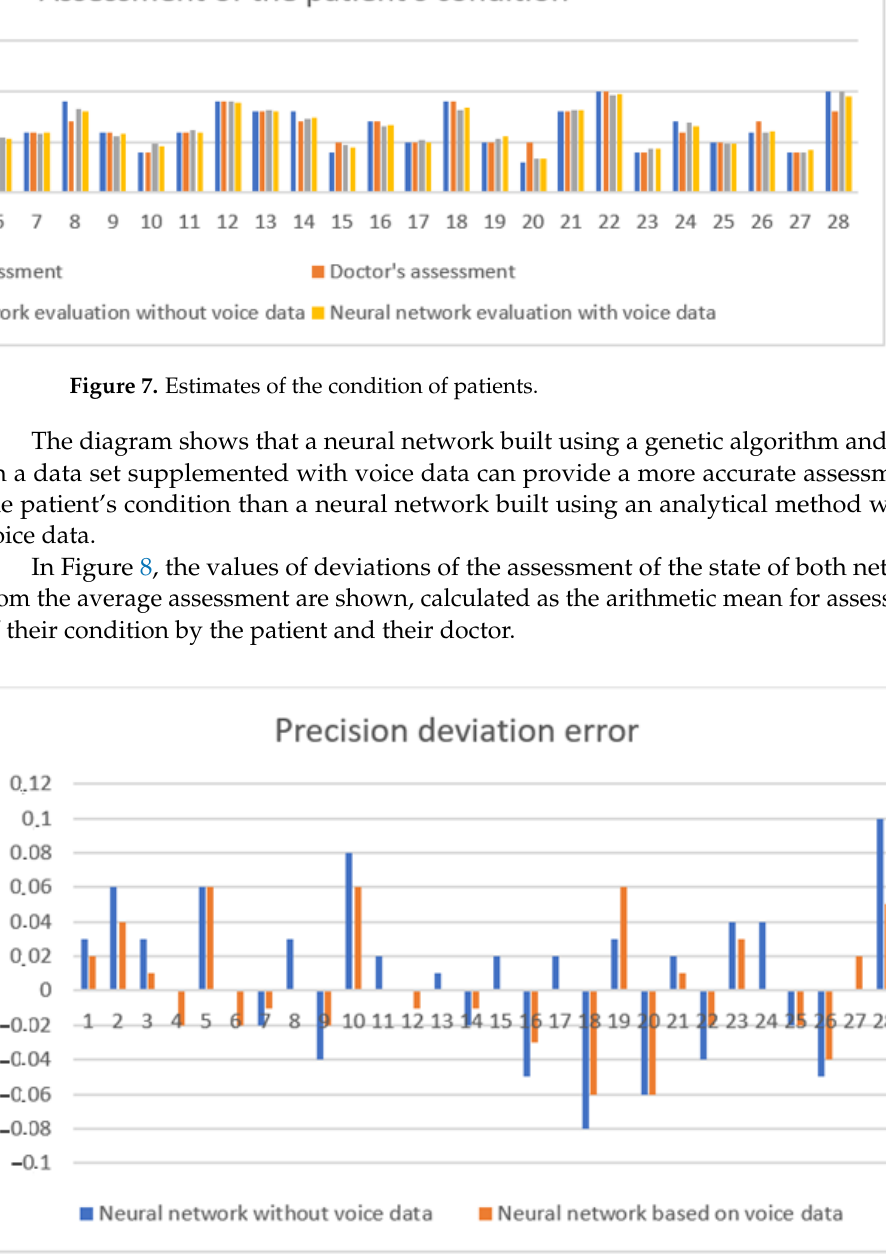
Figure 8. Estimates of the condition of patients.